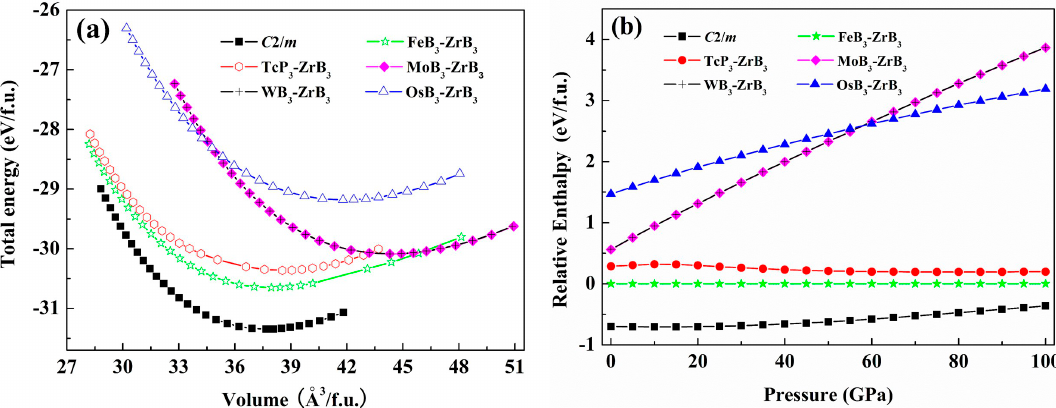
Figure 3. ( a ) Total energy versus f.u. volume for ZrB 3 with six different structures; ( b ) Enthalpies of ZrB 3 with six different structures relative to FeB 3 -ZrB 3 phase as a function of pressure.